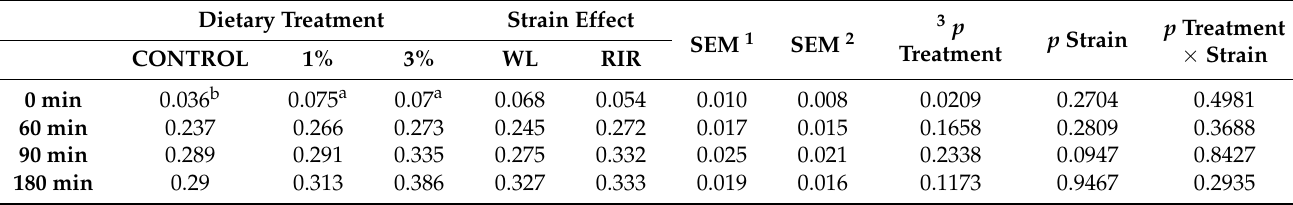
Table 7. Effect of dietary spirulina and strain of laying hens (White Leghorn: WL or Rhode Island Red: RIR) on the iron-induced lipid oxidation (mmol MDA/kg) of yolk at 0, 60, 90 and 180 min of incubation. Dietary Treatment Strain Effect